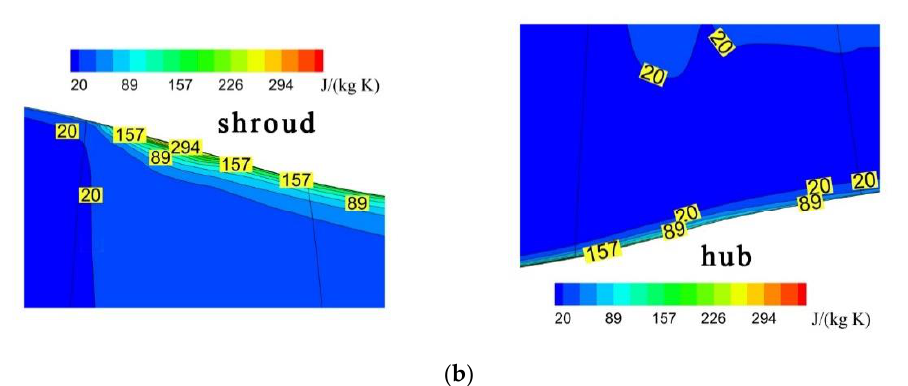
Figure 11. The pitchwise-averaged entropy contours. ( a ) View on the meridional plane and ( b ) View around shroud and hub.